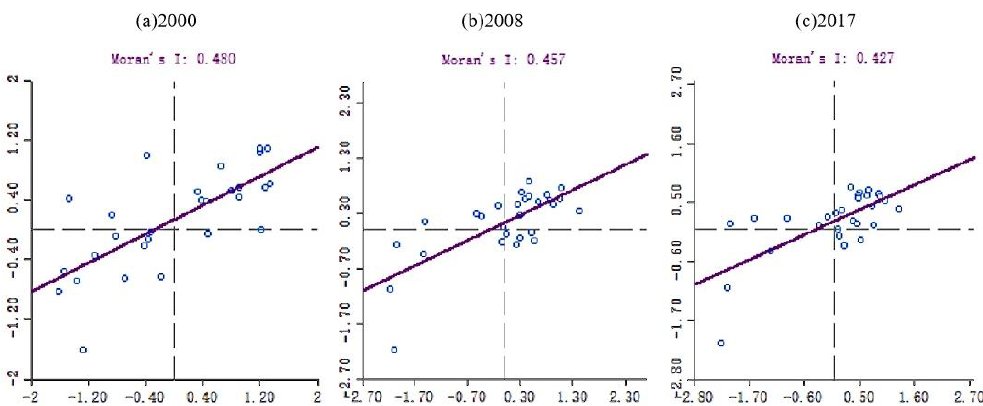
Figure 2. Moran scatter plot of PM 2.5 in Beijing-Tianjin-Hebei region and surrounding cities in 2000, 2008 and 2017.